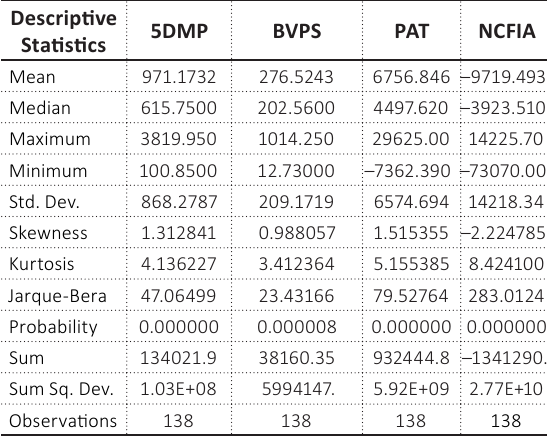
Table 1. Descriptive statistics, pre-Ind